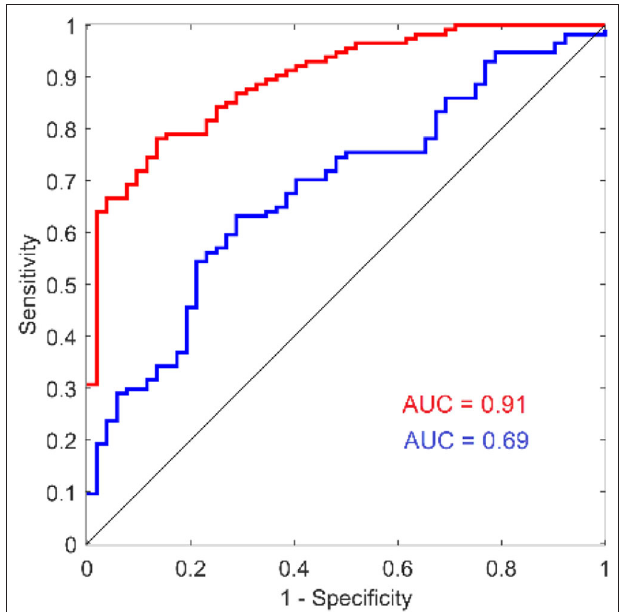
FIGURE 7 | ROC curves for reaction time and reaction time variability from a recent study comparing concussed to non-concussed individuals. Reproduced with modification and with permission from ( Favorov et al.,